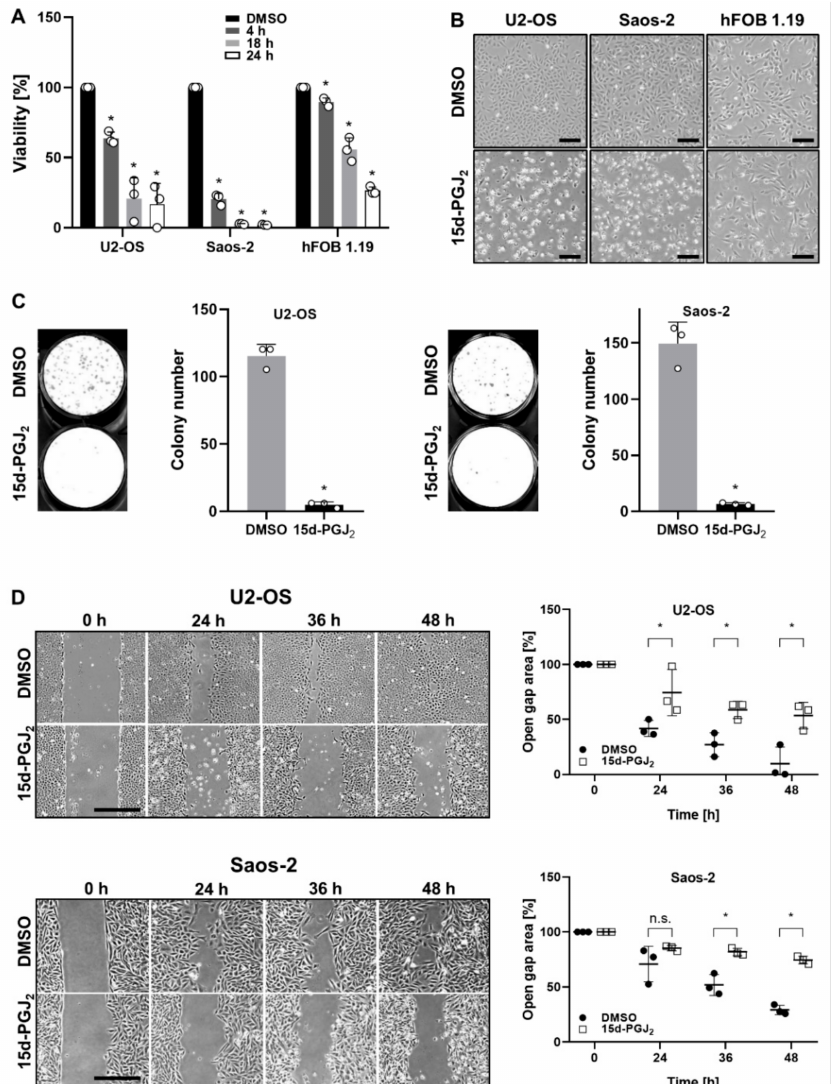
Figure 1. 15d-PGJ 2 inhibits cell growth, colony forming ability and motility of OS cell lines. ( A ) Human OS cell lines (U2-OS and Saos-2) and the human non-malignant osteoblastic cell line hFOB 1.19 were treated with 20 µ M 15d-PGJ 2 for indicated time periods. Cell viability was measured by MTT proliferation assay. DMSO concentration corresponding to the 20 µ M 15d-PGJ 2 (0.04%) was used as a vehicle control. Data are represented as means of three independent experiments and viability of DMSO-treated cells was set to 100% (* p ≤ 0.05). ( B ) Representative images display the change in morphology of OS and hFOB 1.19 cell lines observed upon treatment with 20 µ M 15d-PGJ 2 for 24 h. (scale bar = 100 µ m). ( C ) Representative images (left panel) and bar graphs (right panel) out of three experiments show significant differences between the number of colonies formed by U2-OS and Saos-2 cells after a 10 and 15 day incubation, respectively. Both cell lines were treated for 24 h with 20 µ M 15d-PGJ 2 dissolved in DMSO. DMSO (0.04%) was used as vehicle control. ( D ) U2-OS (upper panel) and Saos-2 OS (lower panel) cells were seeded into 12-well plates containing cell culture inserts with a 500 µ m cell-free gap and grown until approx. 90% confluence before 24 h treatment with 15d-PGJ 2 or DMSO (0.04%) as vehicle control. Inserts were removed and the gap closure was measured and quantified at indicated time periods. Representative images and dot graphs for each cell line (performed in triplicates) are shown. Scale bar = 500 µ m. The dot graphs display the differences in scratch closure at each time point, with zero time point set to 100%. Data are represented as means ± SD. (* p ≤ 0.05; n.s. = not